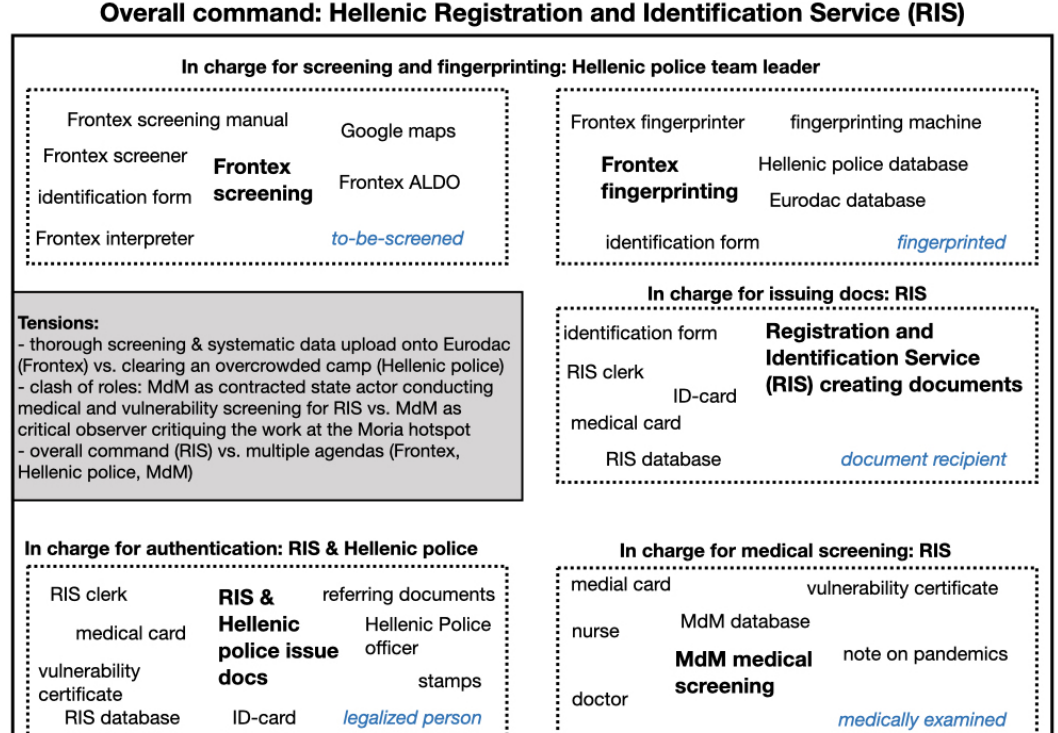
Figure 3. Social world map of the Registration and Identification Centre